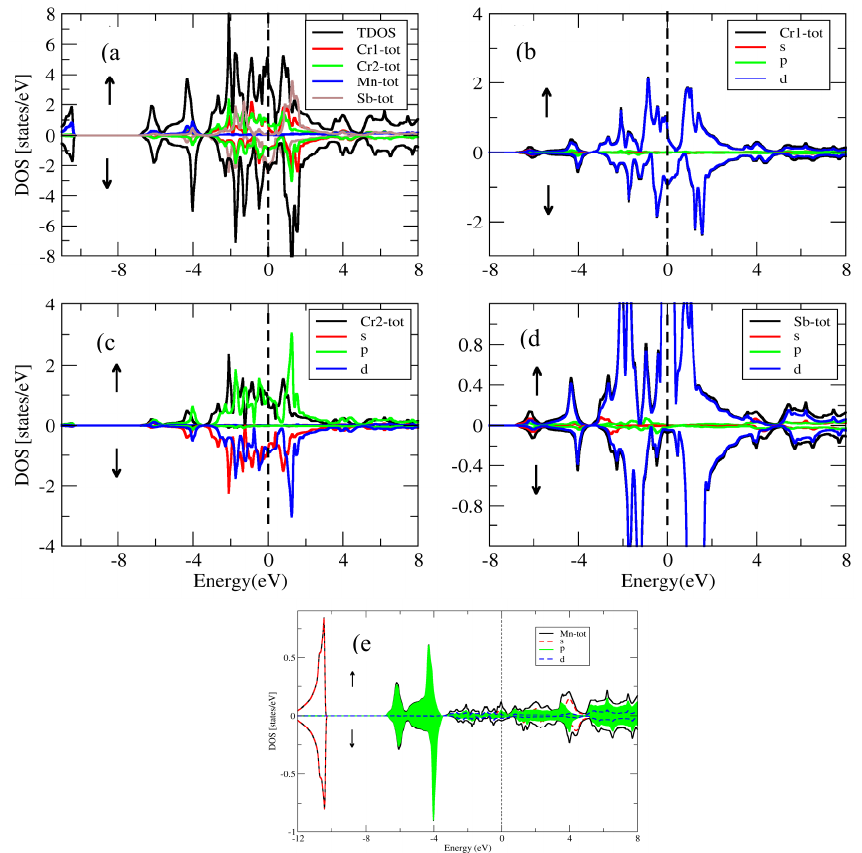
Figure 16. ( a ) Total density of states for the inverse Cr 2 MnSb compound and partial density of states for ( b ) Cr1 atom, ( c ) Cr2 atom, ( d ) Sb atom and ( e ) Mn atom.